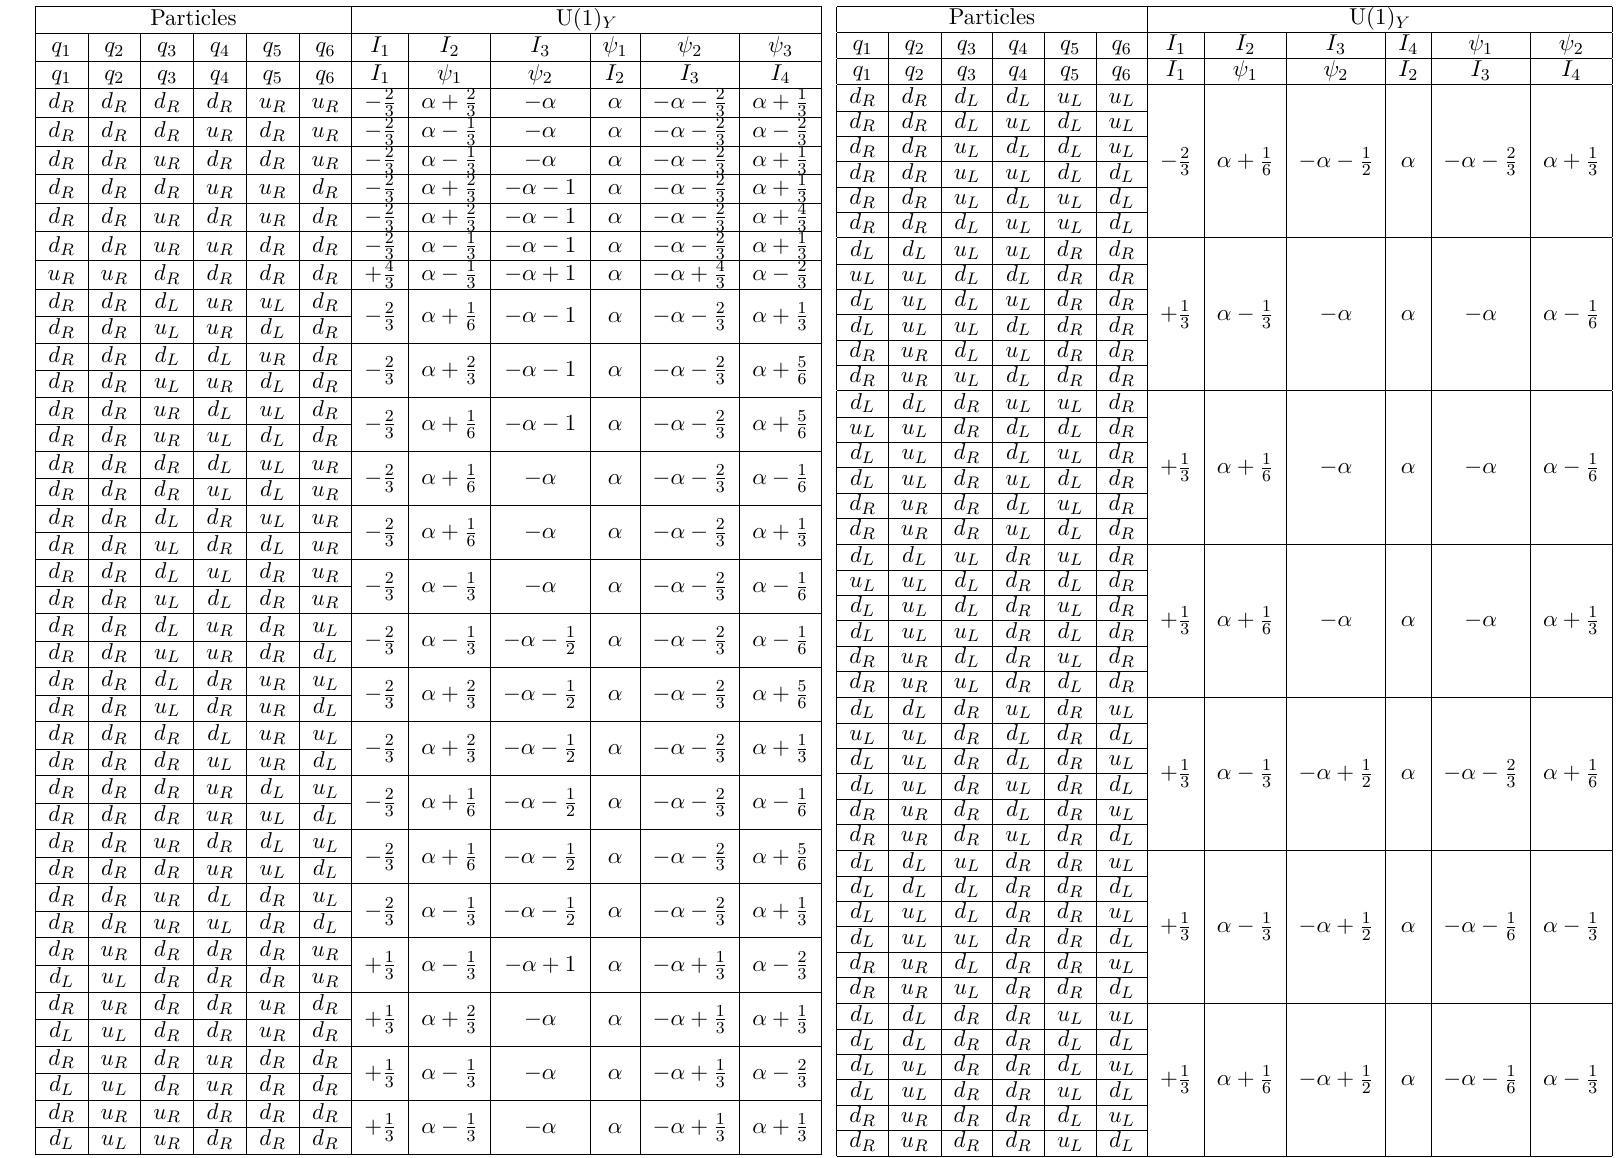
Table 10 . The possible U(1) Y numbers of the fields in